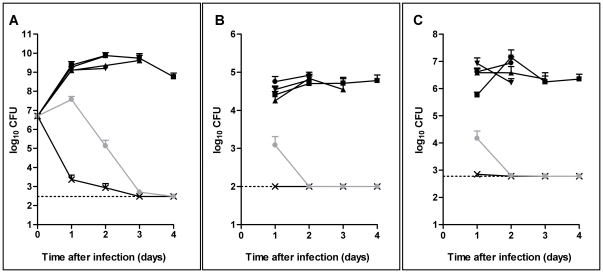
Persistence of Acinetobacter strains in the lungs and extrapulmonary dissemination.Levels of A. baumannii clone I strain RUH875 (black circles), clone II strain RUH134 (black downward triangles), clone III strain LUH5875 (black squares), sporadic strain LUH8326 (black upward triangles) and type strain RUH3023T (black crosses), and A. junii strain LUH5851 (gray circles) in the lungs (A), bloodstream (B) and spleen (C) of mice at 1 to 4 days after intratracheal injection. Results are expressed as mean CFU per g of tissue (for lung and spleen) or CFU per ml (for blood) ± standard errors of the mean of 8 mice except for LUH8326 at 3 days after infection, where n = 4. Values are representative for surviving mice only. Dotted lines represent the lowest limit of detection.